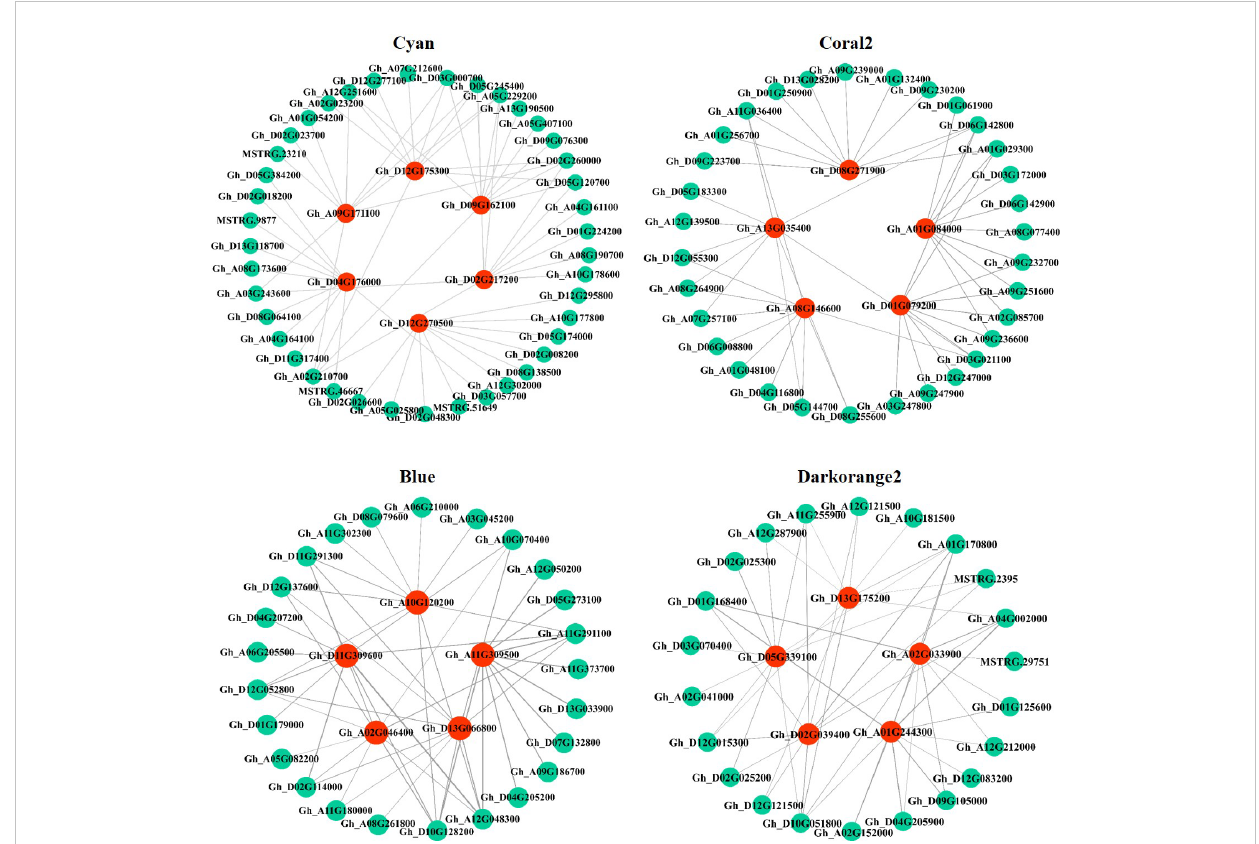
FIGURE 7 Regulatory network diagram of hub genes and associated genes in key modules. Red represents hub genes, blue − green represents the top 10 genes associated with hub